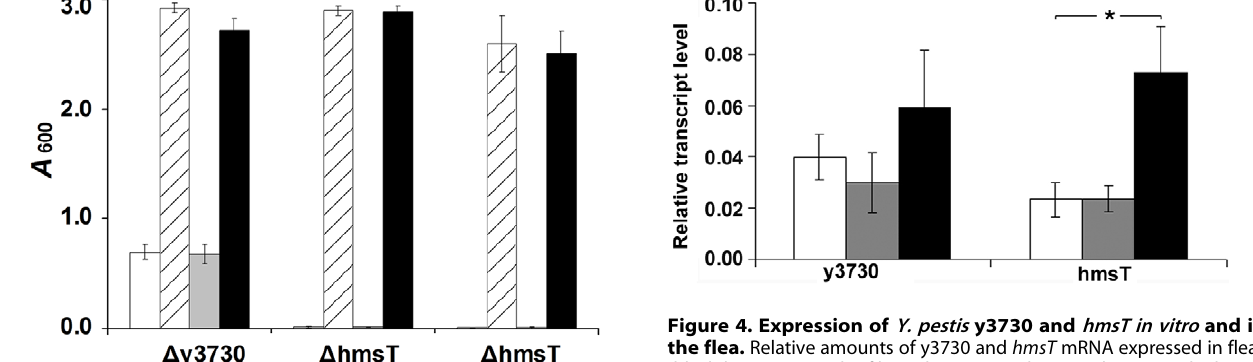
Table 2. Infection and blockage of fleas by Y. pestis strains.